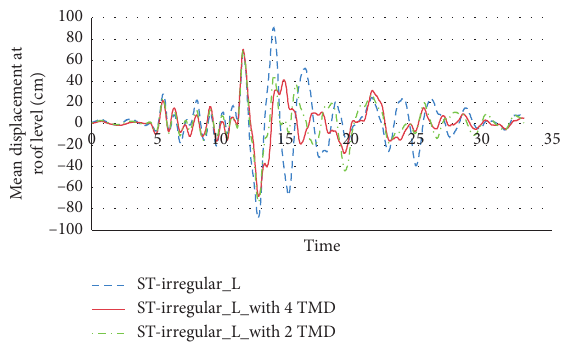
Figure 30: Displacement of the twenty-story irregular L-shaped model with 2 and 4